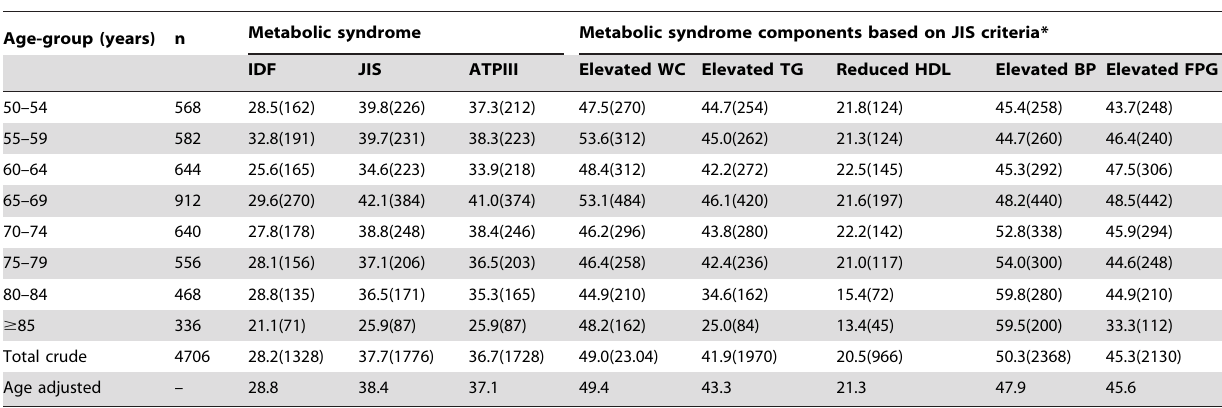
Table 1. Prevalence of metabolic syndrome and its individual components among postmenopausal women in rural Canton